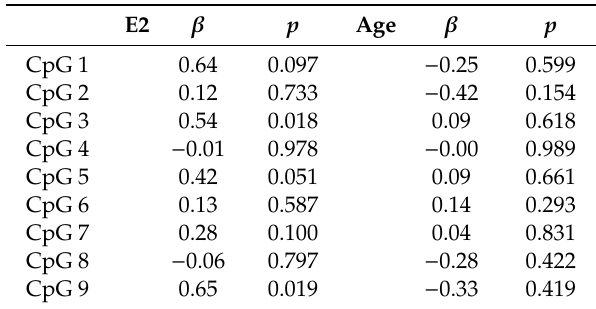
Table 2. E ff ects of estradiol (E2) levels and age on estrogen receptor 1 gene ( ESR1 ) CpGI shore methylation at individual